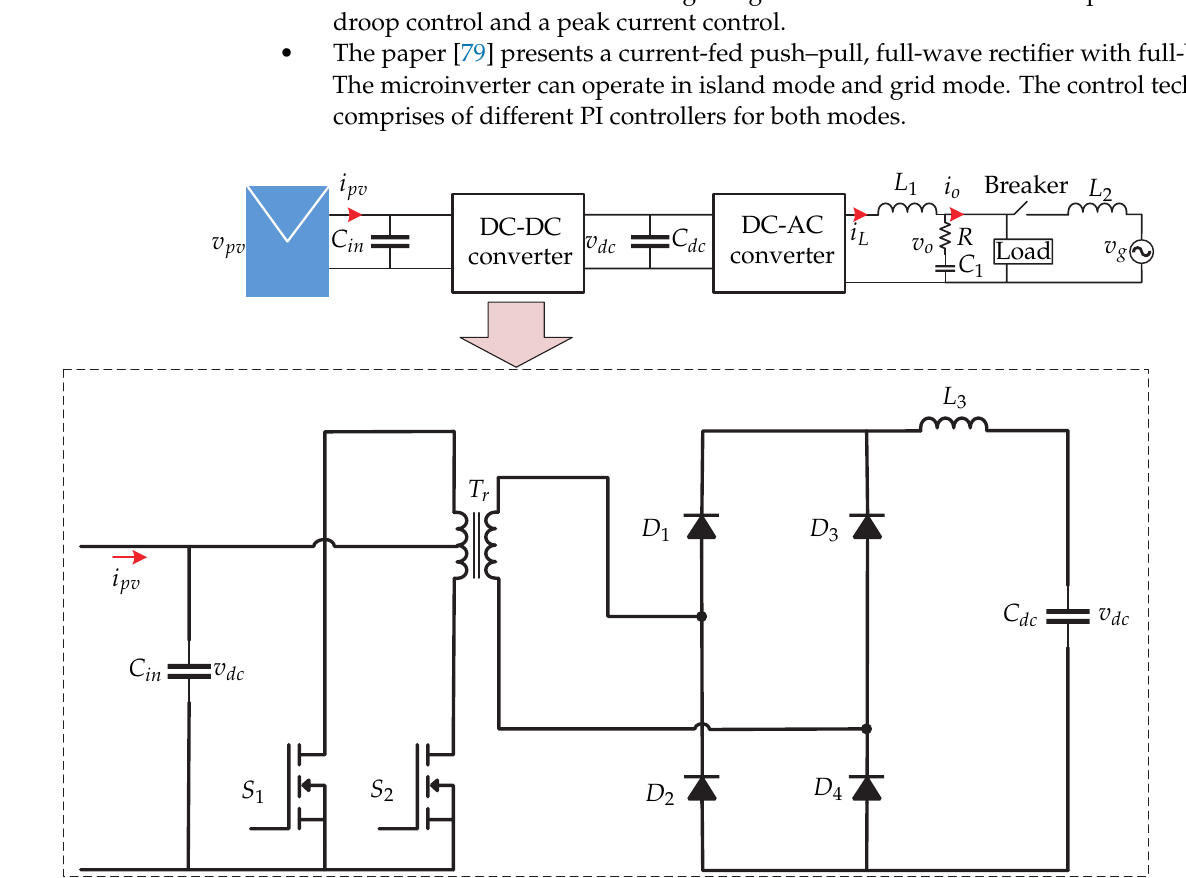
Figure 38. Microinverter’s topology proposed in [74–76].